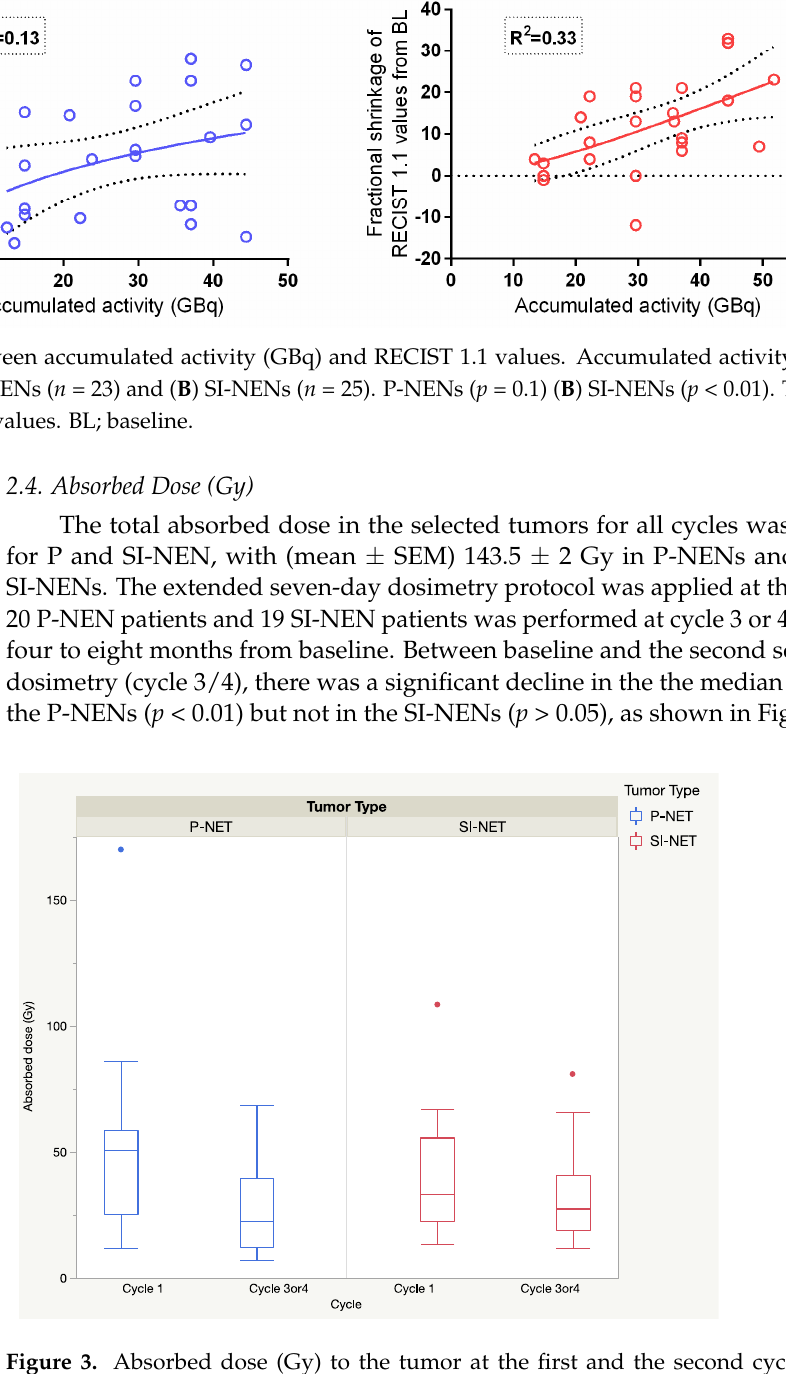
Figure 2. Correlation between accumulated activity (GBq) and RECIST 1.1 values. Accumulated activity (GBq) versus RECIST 1.1 values. ( A ) P-NENs ( n = 23) and ( B ) SI-NENs ( n = 25). P-NENs ( p = 0.1) ( B ) SI-NENs ( p < 0.01). Two patients in each group have identical values. BL;